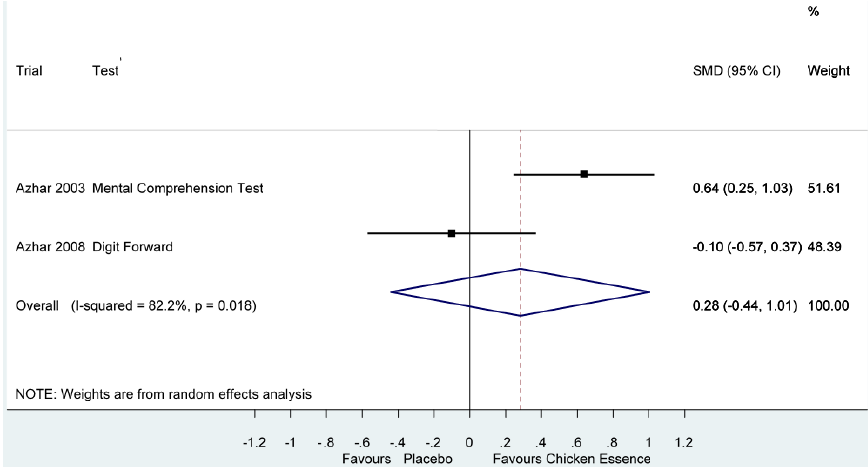
Figure D3. Pooled effect estimate of score of short-term memory tests (with Azhar’s test removed [2]). Nutrients 2016 , 8 , 57 24 of 25